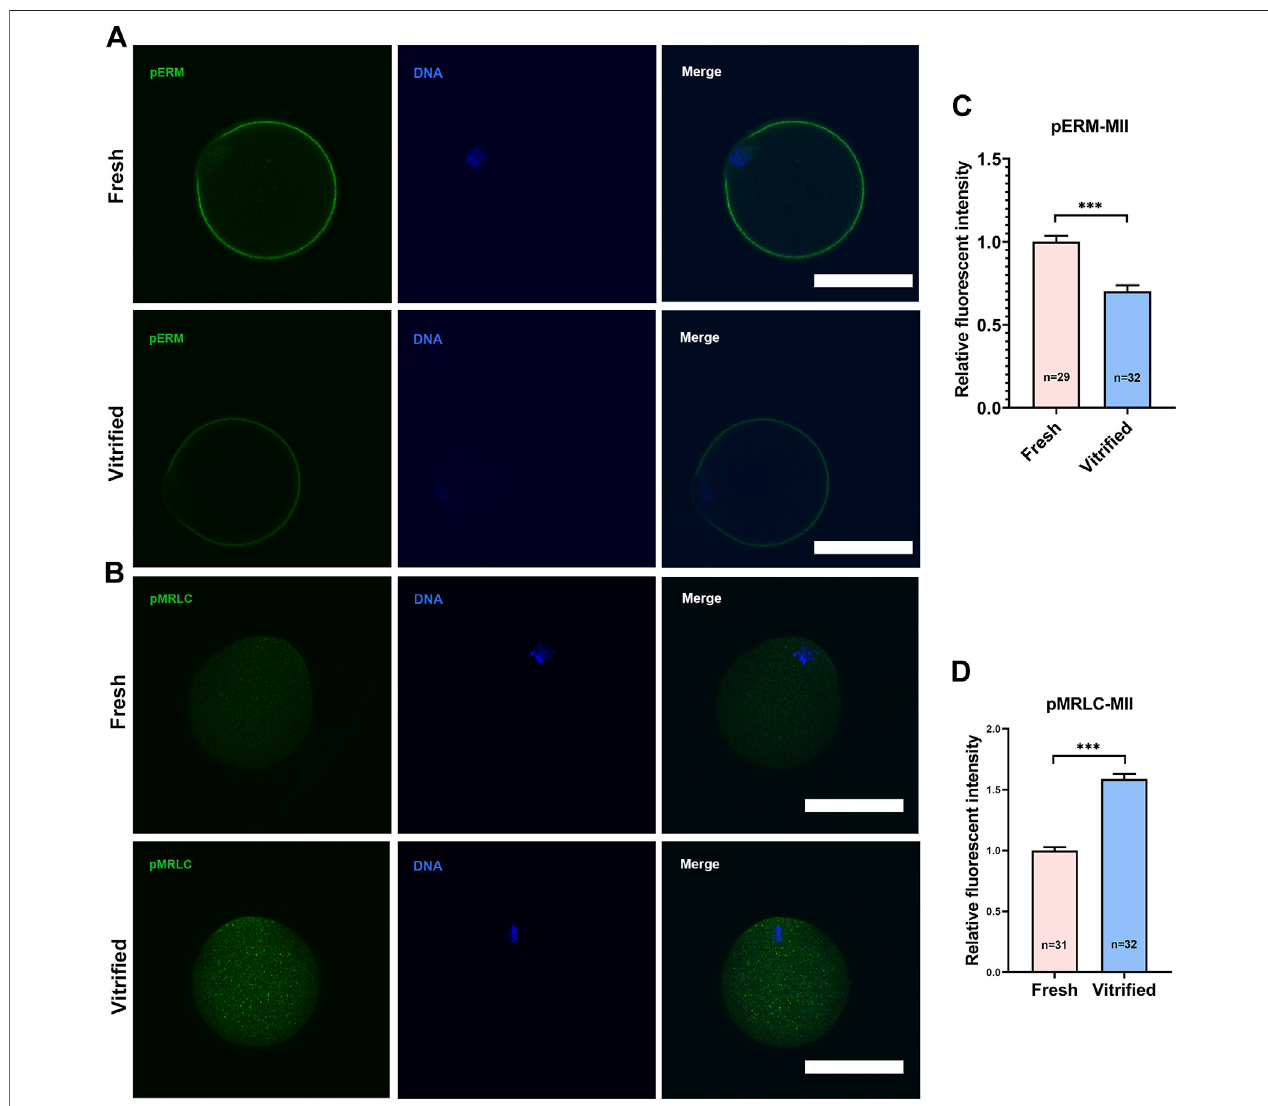
FIGURE 2 | Vitri fi cation induced a signi fi cant decline in cortical tension in MII oocytes. (A) Representative images of pERM staining in MII oocytes. Scale bar = 50 μ m. (B) Representative images of pMRLC staining in MII oocytes. Scale bar = 50 μ m. (C) Quanti fi cation of the relative pERM fl uorescence intensity in fresh ( n = 29) and vitri fi ed ( n = 32) MII oocytes. (D) Quanti fi cation of the relative cytoplasmic pMRLC fl uorescence intensity in fresh ( n = 31) and vitri fi ed ( n = 32) MII oocytes. Data were presented as mean percentage (mean ± SEM) of at least three independent experiments. * p < 0.05, ** p < 0.01, *** p < 0.001.